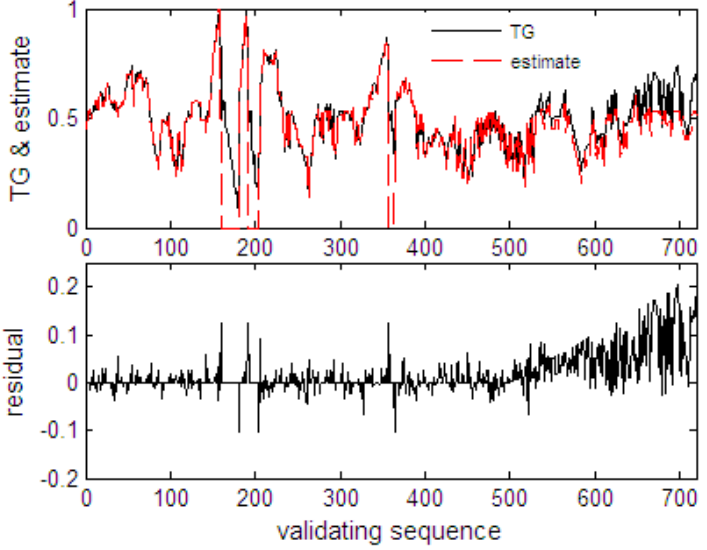
Figure 10. AAKR model estimate and residual in Case